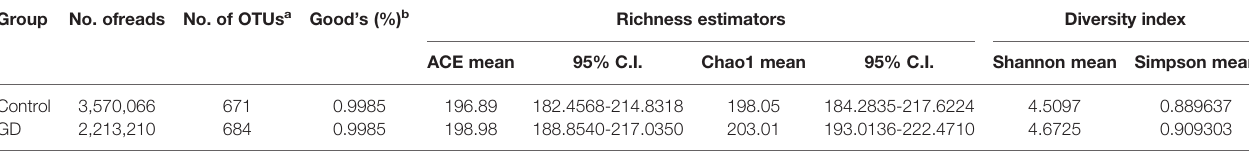
TABLE 2 | Phylotype coverage and diversity estimation of the 16S rRNA gene libraries at 97% similarity from the MiSeq analysis. Group No. ofreads No. of OTUs a Good ’ s (%)